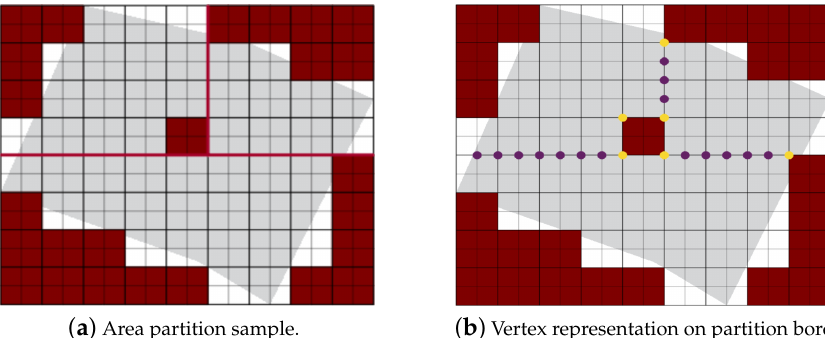
Figure 7. Partition borders vertex